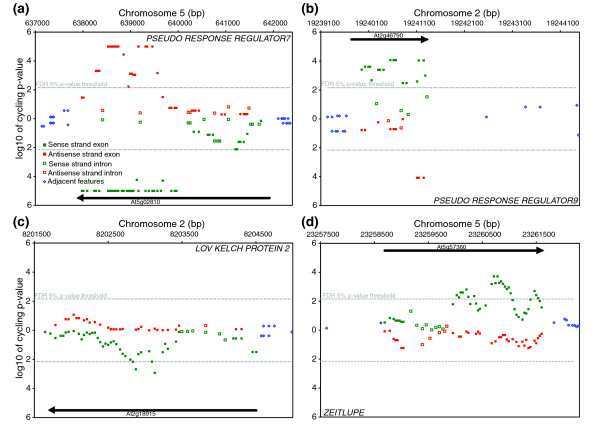
The Arabidopsis tiling arrays portray several interesting classes of circadian behavior in the genome. Each symbol is a feature on the tilling array showing location in the genome (x-axis) and significance of the spectral analysis (y-axis) for (a) PSEUDO RESPONSE REGULATOR7, (b) PSEUDO RESPONSE REGULATOR9, (c) LOV KELCH PROTEIN2, and (d) ZEITLUPE. The top half of each panel displays the Watson strand and the bottom half the Crick strand. Individual features that exceed the false discovery rate 5% p-value threshold (-) are considered to have a circadian rhythm.